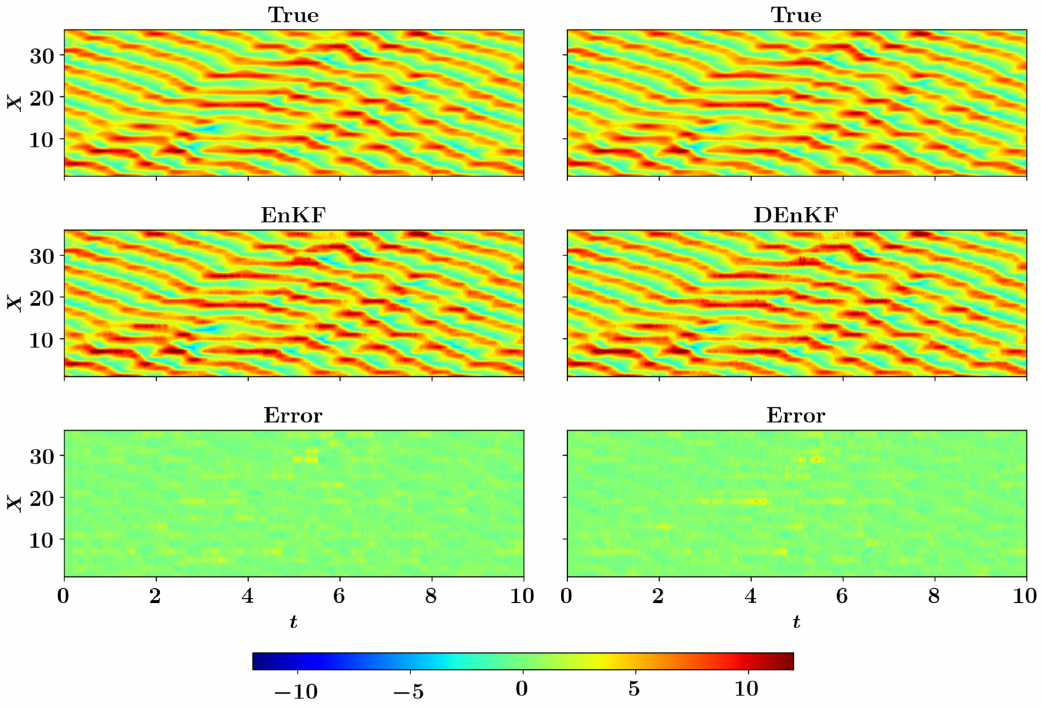
Figure 10. Full state trajectory of the multiscale Lorenz 96 model with no parameterizations in the forecast model. The EnKF algorithm uses the inflation factor λ = 1.04 and N = 50 and the DEnKF uses the inflation factor λ = 1.05 and N = 45. The observation data for both EnKF an DEnKF algorithm is obtained by adding measurement noise to the exact solution of the two-level Lorenz 96